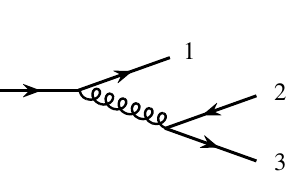
Figure 3. Calculation of the n f contribution in the squeezed limit using iterated splitting functions. The non-trivial azimuthal dependence arises from the interference between the splittings of gluons of different